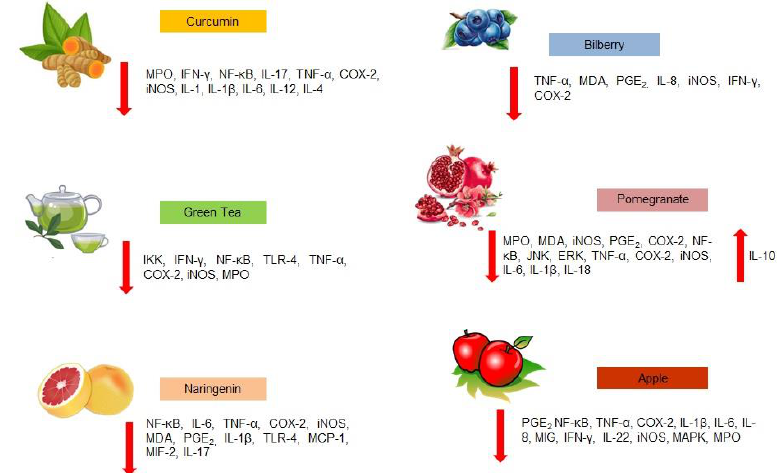
Figure 1. Molecular mechanisms of most investigated vegetable-derived biophenols (other than olive-derived) potentially involved in inflammatory bowel disease treatment. The red arrows pointing up indicate an increase while the red arrows pointing down indicate a decrease. MPO: myeloperoxidase; IFN- γ : interferon-gamma; NF- κ B: nuclear factor kappa-light-chain-enhancer of activated B cells; MAD: malondialdehyde; PGE 2 : Prostaglandin E2; TLR-4: toll-like receptor-4; IL: interleukin; TNF- α : tumor necrosis factor-alpha; COX-2: cyclooxygenase-2; IKK: I kappa B kinase; iNOS: inducible nitric oxide synthase; JNK: c-Jun N-terminal kinase; ERK: extracellular signal regulated kinases; MIF-2: macrophage migration inhibitory factor-2; MCP-1: monocyte chemoattractant protein-1; MAPK: mitogen-activated protein kinase; MIG: monokine induced by gamma interferon.